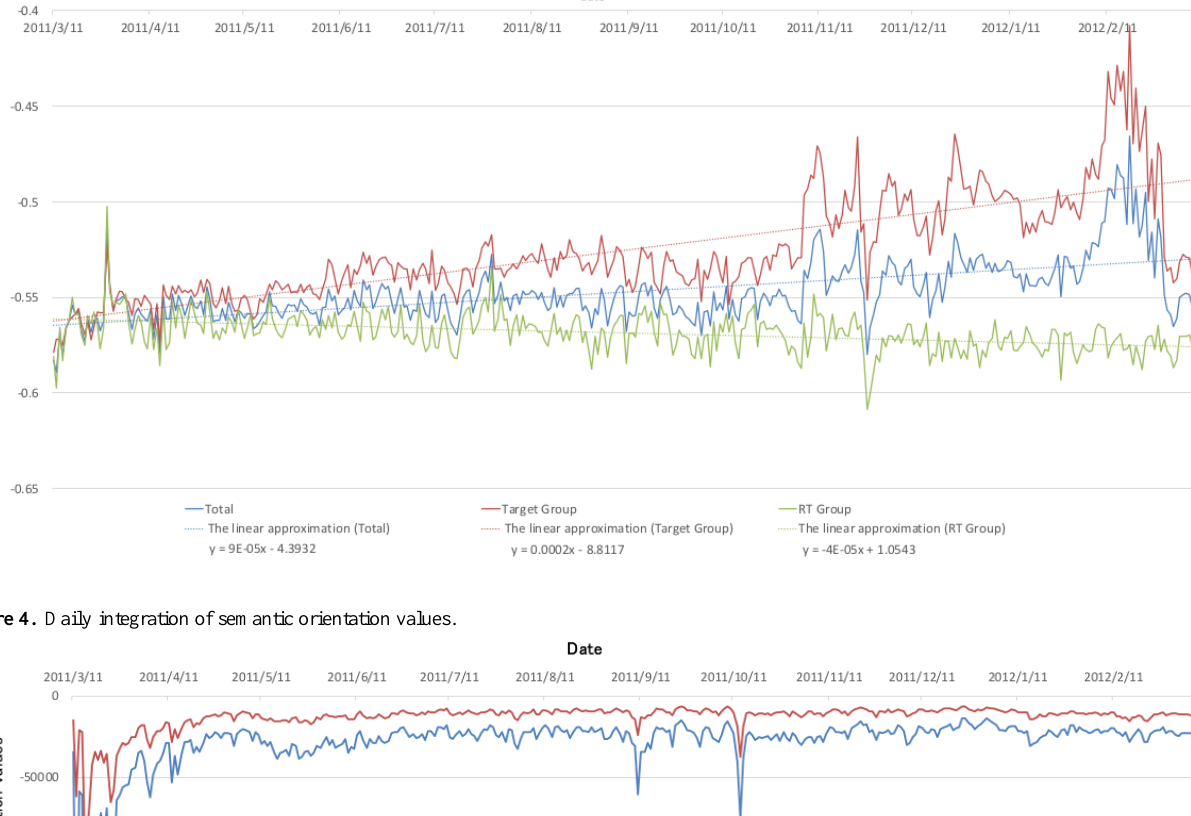
Figure 3. Daily average of tweets' semantic orientation values. RT: retweet.